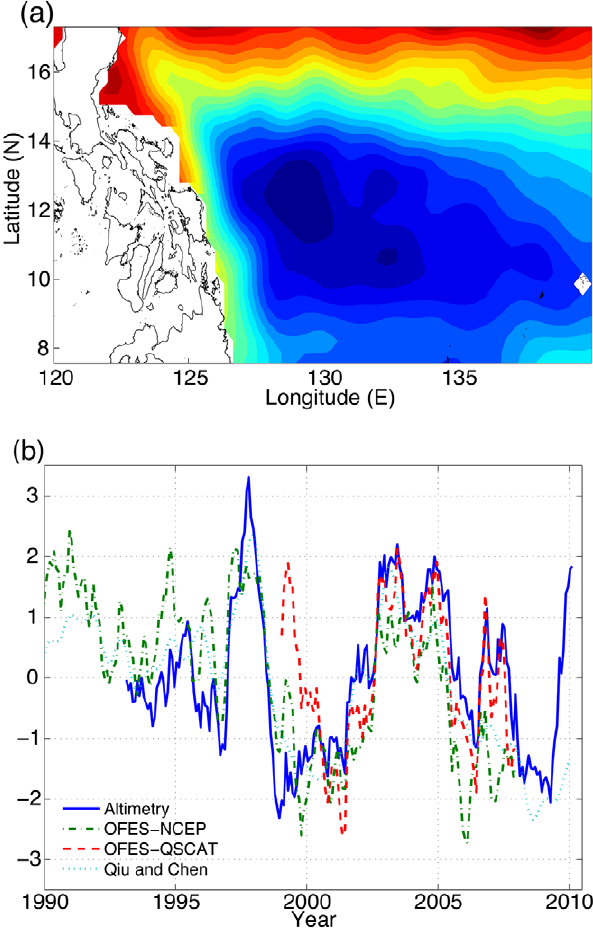
Figure 2. Index for latitudinal shift of NEC bifurcation. In (a), the contour illustrates the first EOF mode of the area east of Philippines from the altimetry data. In (b), time series represent the normalized PC1 for the altimetry data and the OFES model results forced by NCEP and QSCAT wind, respectively. The normalized NEC bifurcation latitude determined by Qiu and Chen (2010b) is also shown. The time series from four calculations show strong coherence.